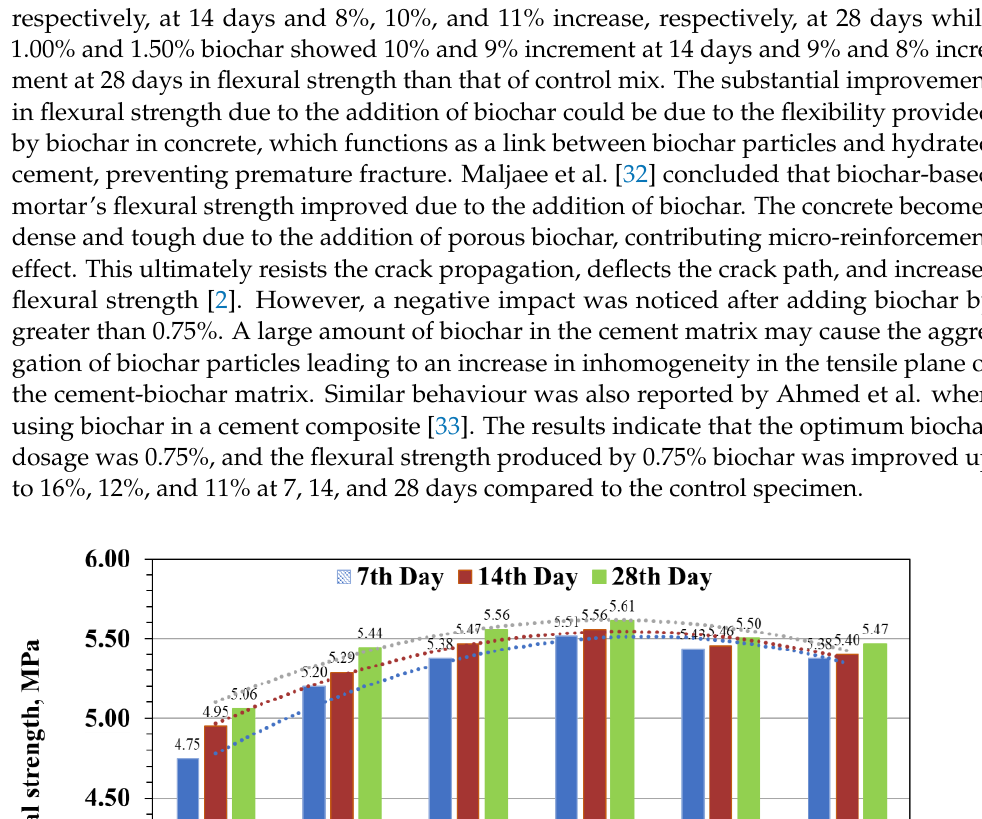
Figure 8. Ultrasonic pulse velocity for various concrete specimens.